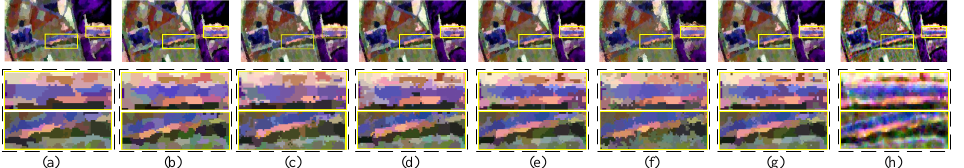
Figure 17. Enlarged region C of the AIRSAR data set. ( a ) POL-SLIC. ( b ) POL-LSC. ( c ) POL-HLT. ( d ) WS. ( e ) HAWS. ( f ) HAGS. ( g ) The proposed HCI. ( h ) Pauli-RGB